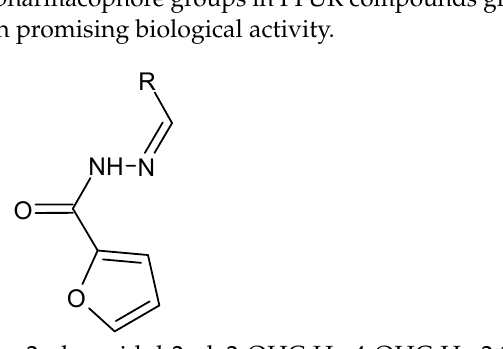
Figure 10. The structure of furanyl-N-acylhydrazone derivatives.